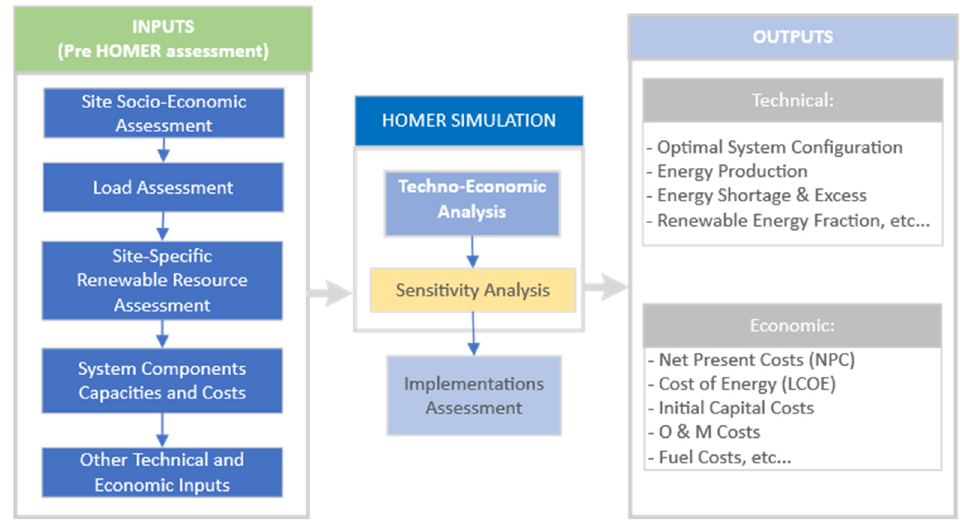
Figure 2. The techno-economic analysis process using HOMER.